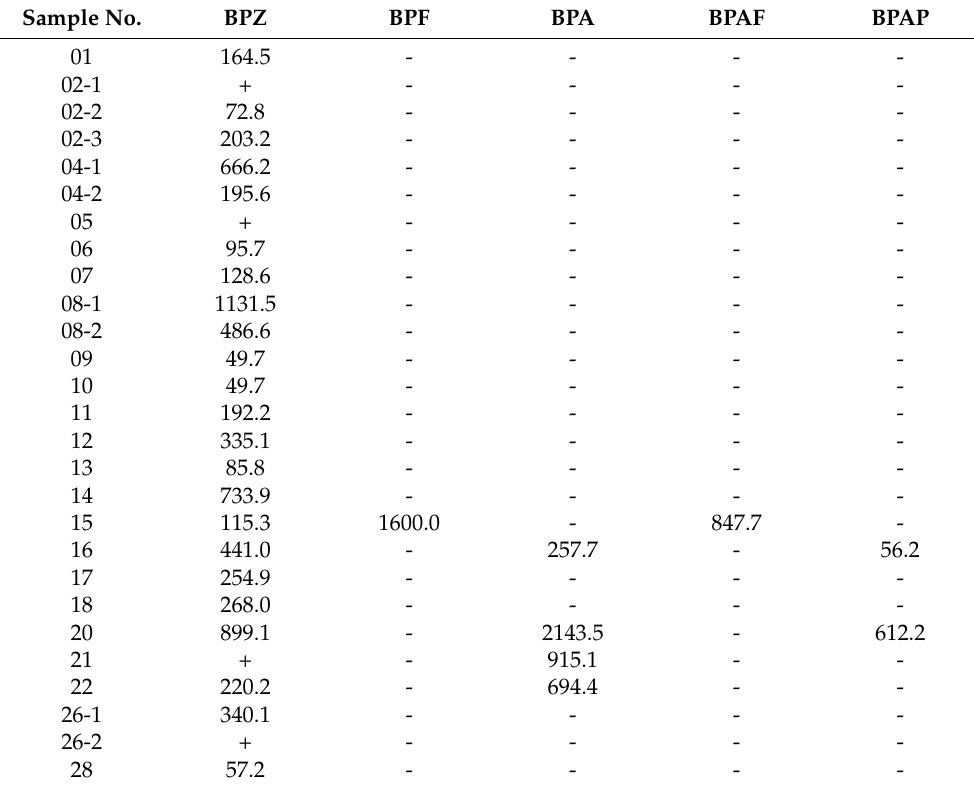
Table 3. Contamination levels of BPs in drinking water samples from local markets (pg/mL). Sample